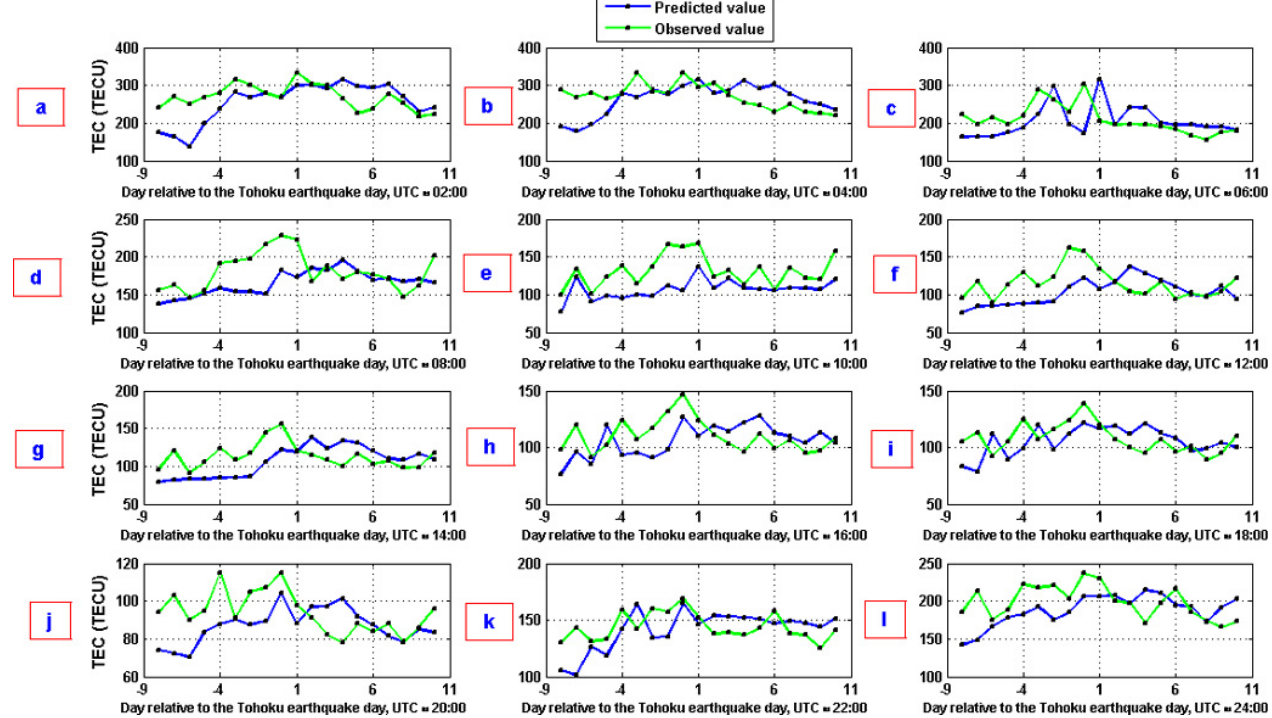
Fig. 2. Variations of the observed (green curve) and predicted (blue curve) TEC values on days selected as testing set at different universal times. The x-axis represents the day relative to the Tohoku earthquake